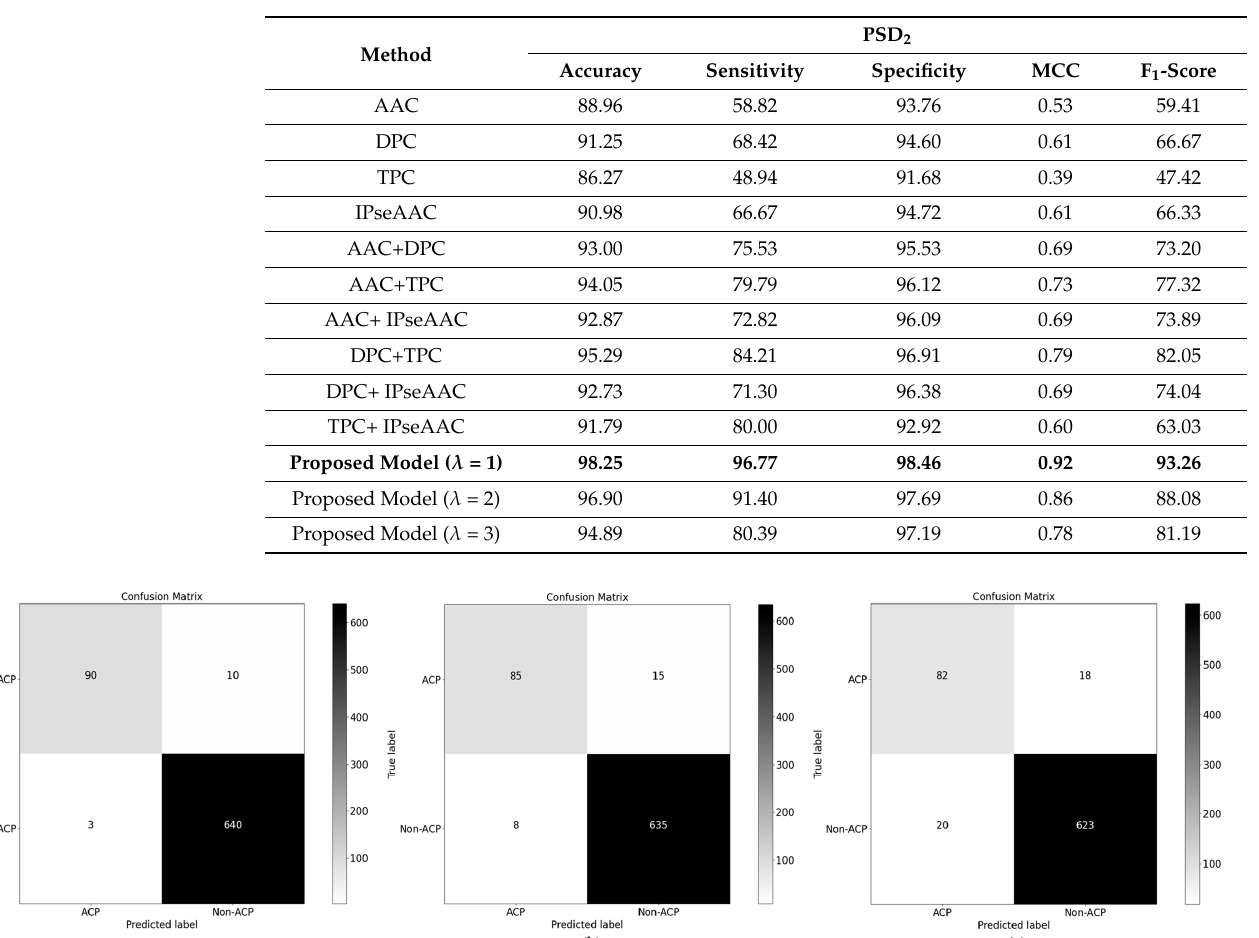
Table 4. Empirical results of numerous collections of feature extraction techniques over the main dataset using PCA and ensemble classifier where bold value represents the best performance.